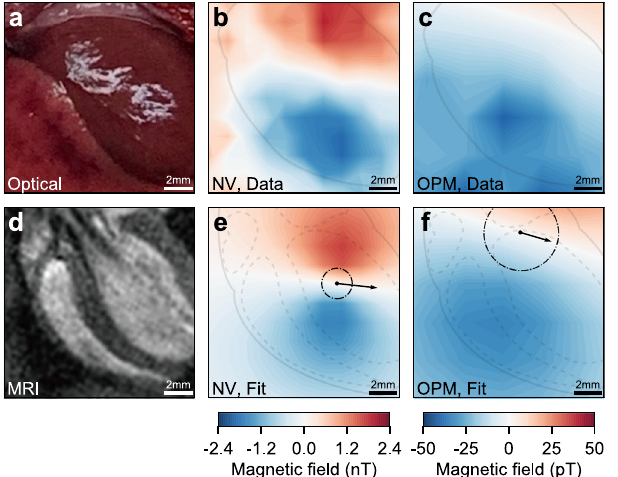
Fig. 4 Estimation of the spatiotemporal dynamics of the cardiac current. a Measured fi eld map at the R-wave peak, superimposed on the contour of the structure of the rat ’ s heart revealed by optical imaging and magnetic resonance imaging (MRI). The black solid line is a linecut connecting the centres of the observed positive and negative magnetic fi eld peaks. b Vector plots of the electric current density calculated using b fi eldtools with a standoff distance of d NV Q ¼ 8 : 1 ± 0 : 7 mm. As a guide for an eye, the MRI image is superimposed in greyscale. c Normal component of the electric current density vector with respect to the linecut. The green shaded region shows the uncertainty of the current density estimated from the uncertainty of the standoff distance (one standard deviation) obtained in the dipole fi tting. d – f Measured fi eld map ( d ), estimated electric current density ( e ), and electric current density across the linecut ( f ) evaluated at 20 ms after the R-wave